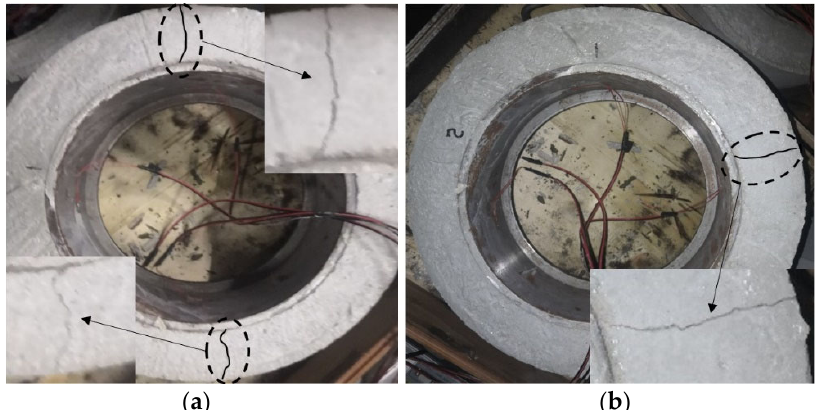
Figure 5. Cracks in concrete rings (the left is J0, and the right is G0). ( a ) Two cracks appeared in the concrete ring; ( b ) A crack appeared in the concrete ring. concrete ring; ( b ) A crack appeared in the concrete